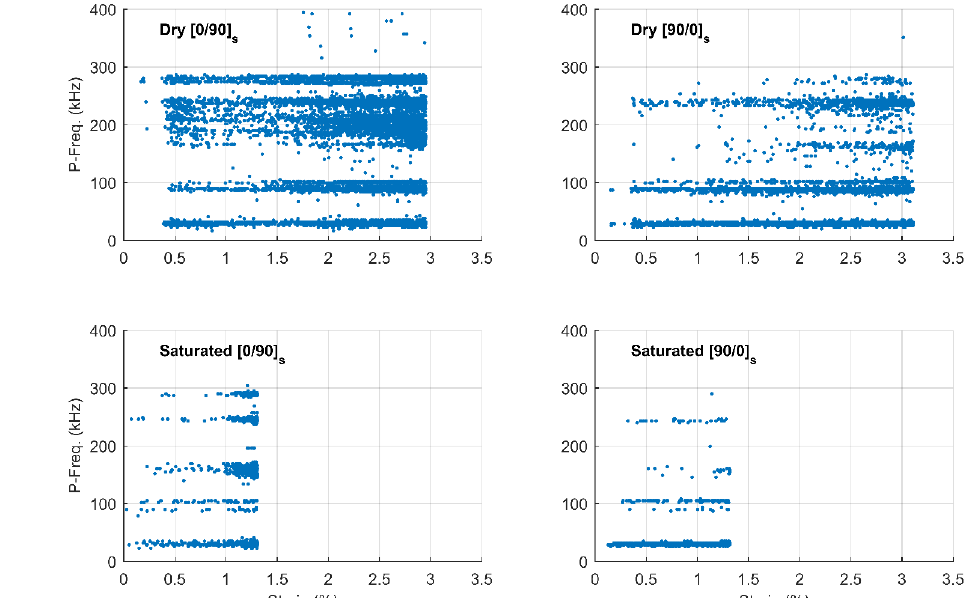
Figure 12. Typical event peak frequency versus strain for four-ply